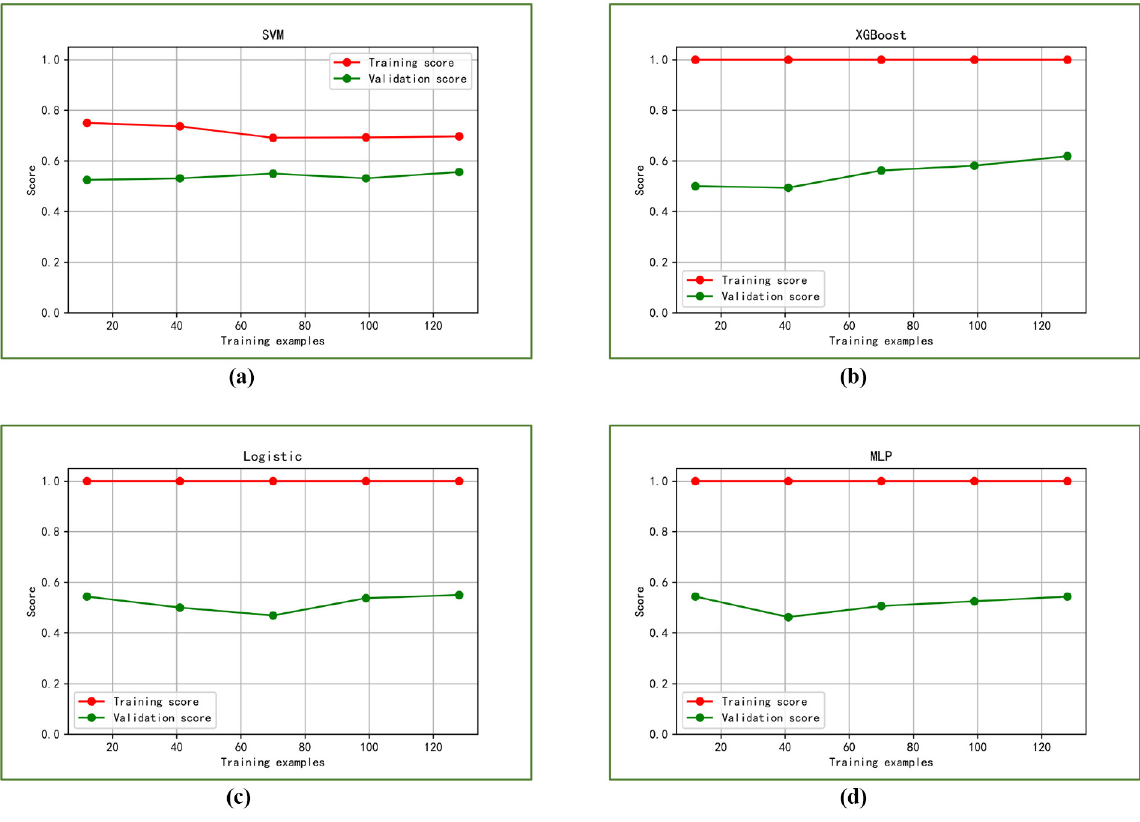
Figure 14 Cross-validation results of different machine learning